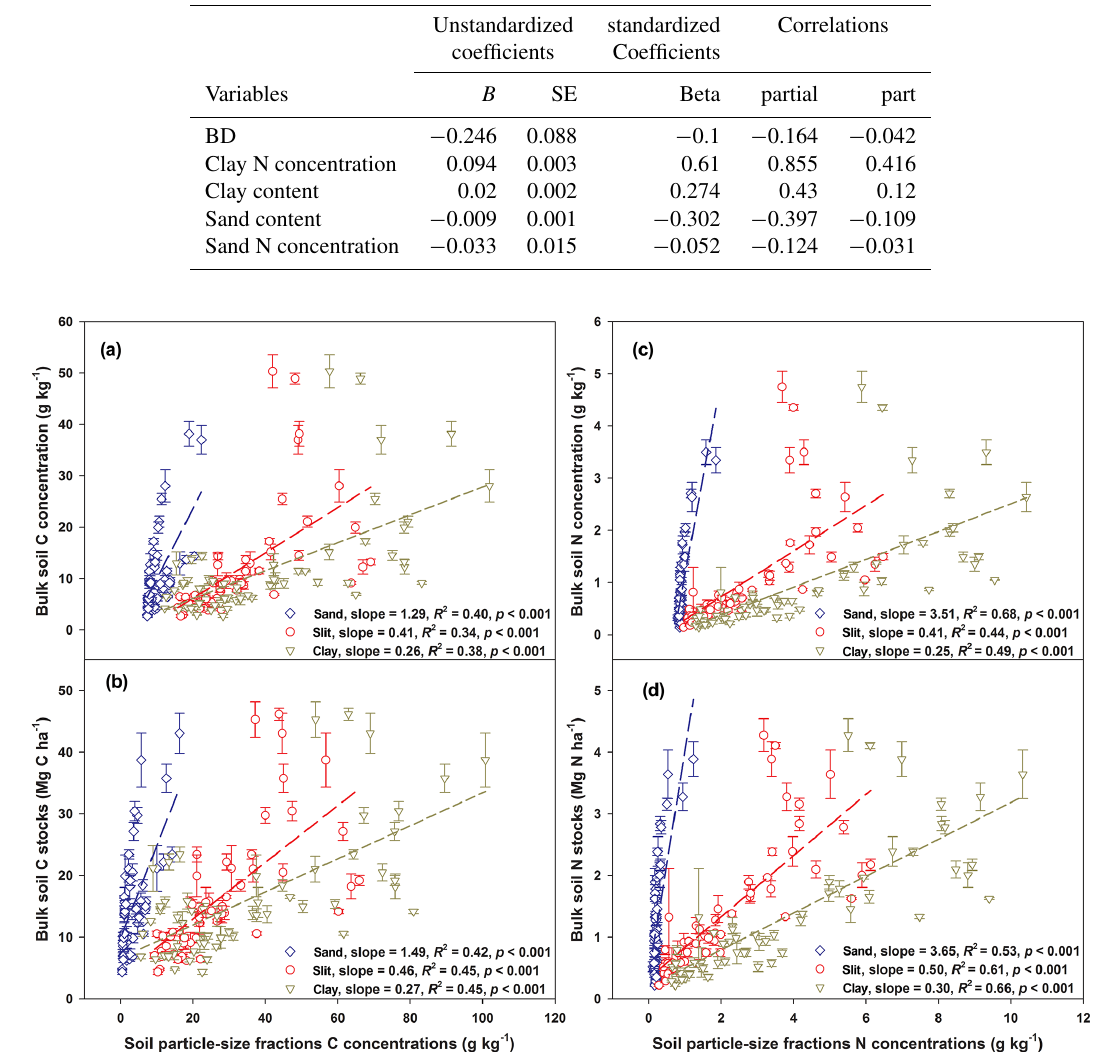
Table 4. Results of the multiple regressions refer to the final accepted model which just included the effects of the significant variables for N stocks in bulk soils of arid and semi-arid grasslands.